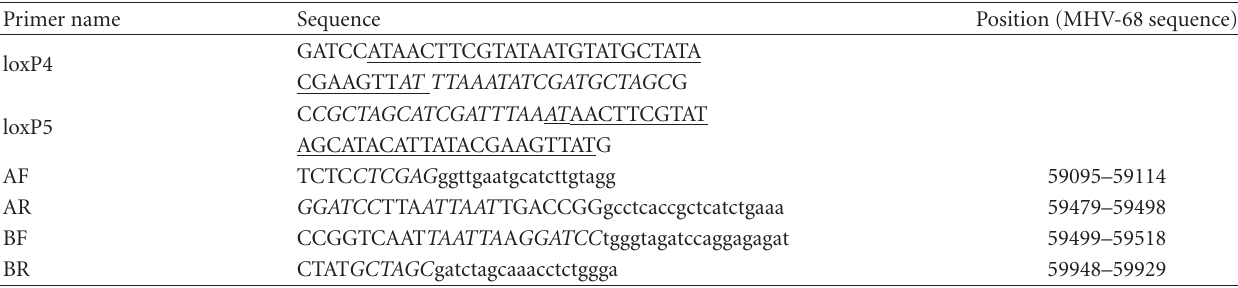
Table 1: Sequences of the